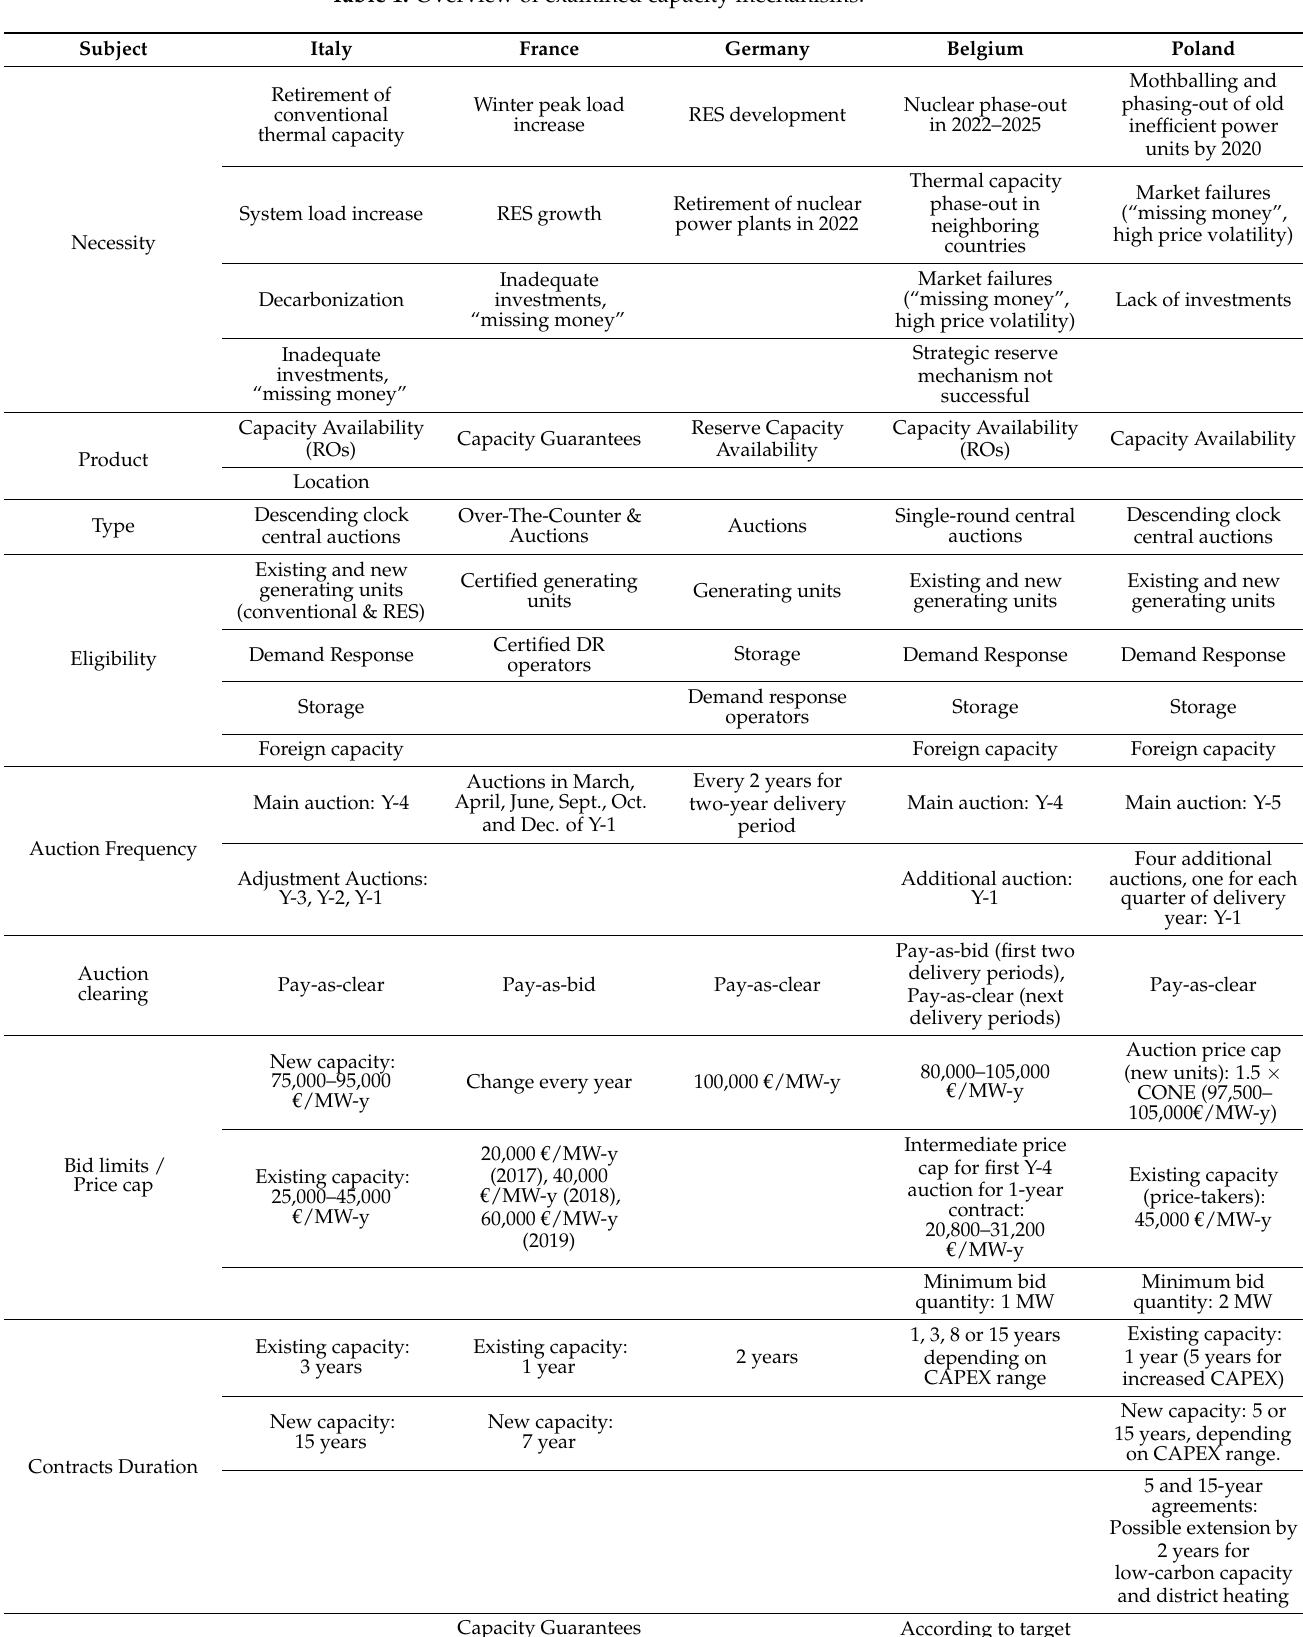
Table 1. Overview of examined capacity